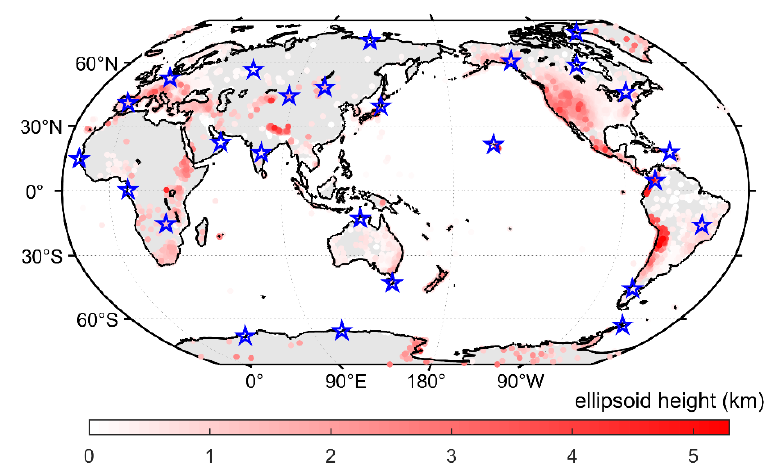
Figure 2. Distribution of global NGL stations. Colors represent the ellipsoids of the corresponding sites. The blue pentagrams represent the stations used for power spectral density (PSD) analysis.